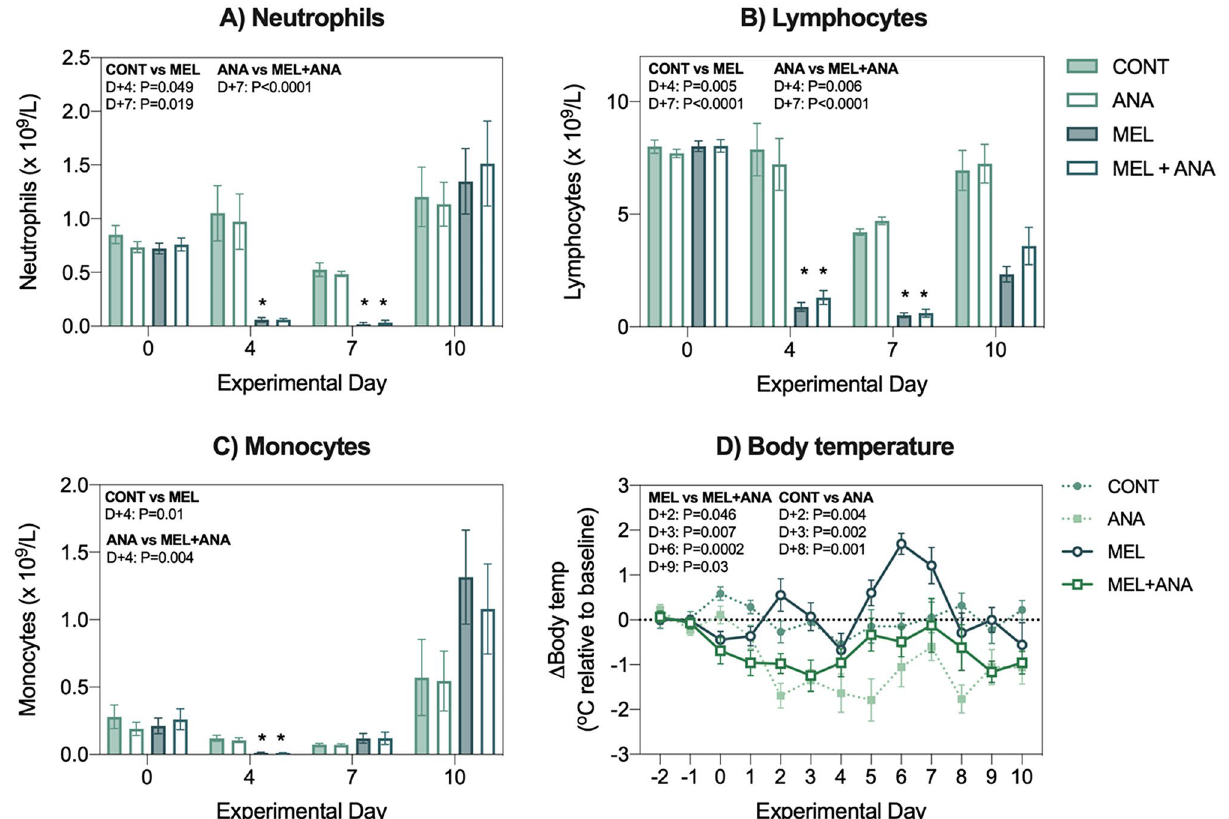
Figure 3. Anakinra does not impair the myeloablative properties of melphalan but controls fever. ( A ) Neutrophils, ( B ) lymphocytes and ( C ) monocytes assessed in whole blood at termination. Melphalan induced fever ( D ), which was controlled by anakinra. Data presented as mean ± SEM. N = 8/group with all data analyzed using mixed-effects model with Geisser-Greenhouse correction for multiple